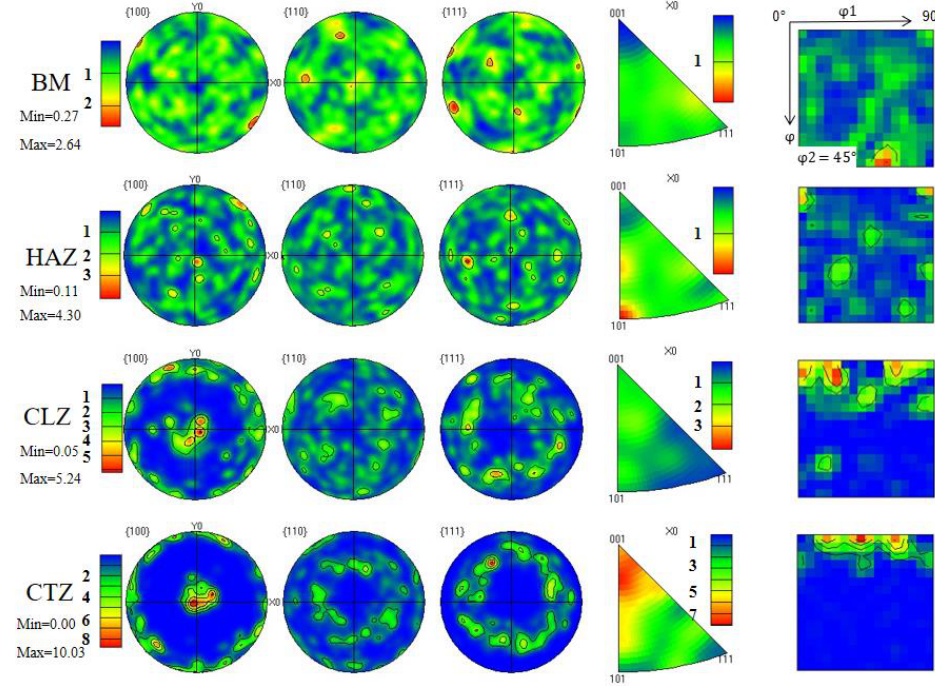
Figure 13. Corresponding pole diagram, reverse pole diagram, and ODF diagram of each area of the sample after 720 mA electron beam scanning ( φ2 = 45°). sample after 720 mA electron beam scanning ( ϕ 2 = 45 ◦